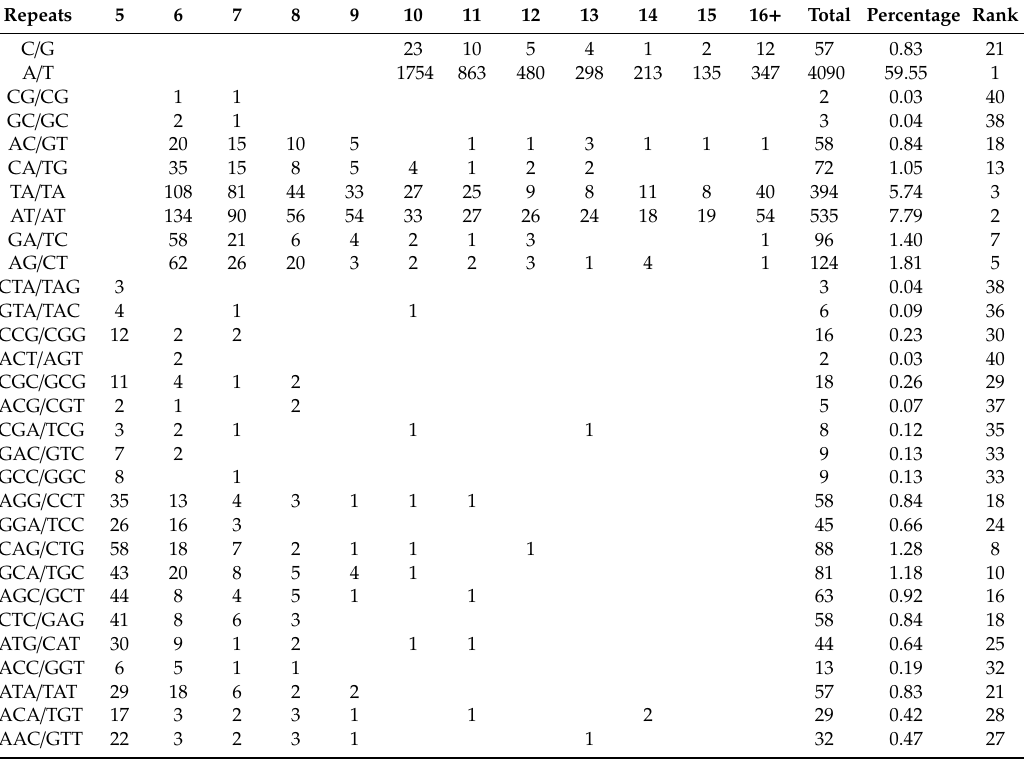
Table 3. Frequencies of di ff erent repeat motifs in SSRs in Pinus koraiensis